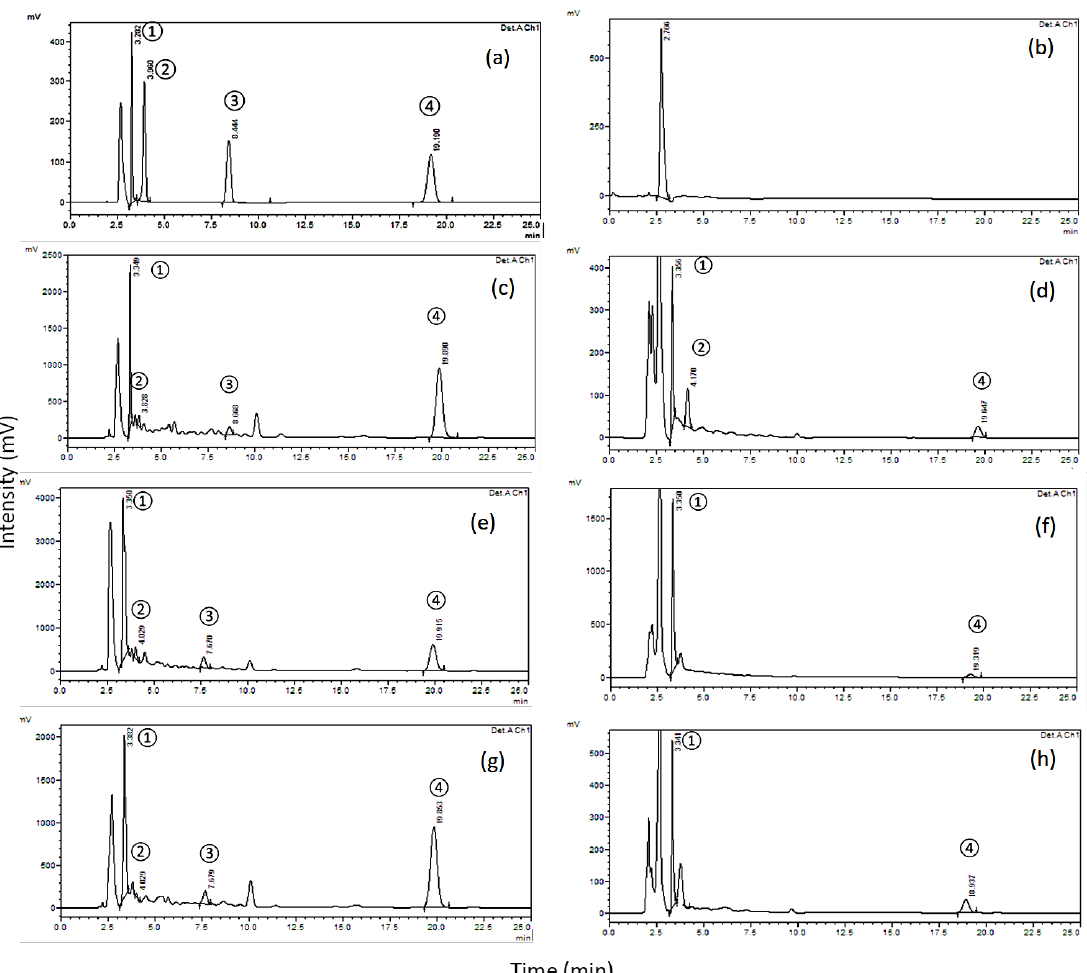
Figure 2. HPLC-RP chromatograms (at 210 nm) of: ( a ) 0.16 µg/mL standards mixture of (1) gallic acid, (2) catechin, (3) scopoletin, and (4) umckalin obtained at retention times of 3.3, 3.96, 8.4 and 19.2 min, respectively; ( b ) Blank (methanol); ( c ) Kalobin ® solution extracted with ethyl acetate; ( d ) Kalobin ® solution extracted with methanol; ( e ) Umca ® solutions extracted with ethyl acetate; ( f ) Umca ® solutions extracted with methanol; ( g ) Umca ® tablets extracted with ethyl acetate; and ( h ) Umca ® tablets extracted with methanol.